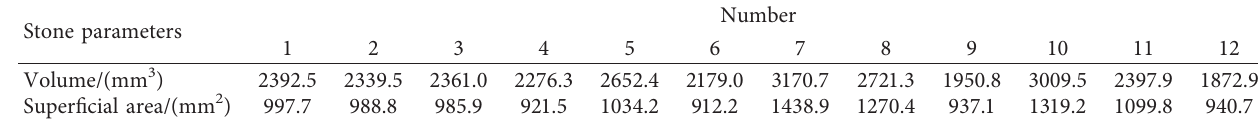
Figure 1: The subcircular and angular test stones and their 3D scanning images. (a) Test stone. (b) The test stones were Table 1: Specific parameters of 3D scanned stones.